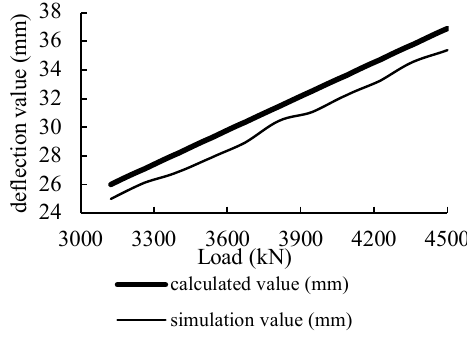
Figure 10. Data validation curve.